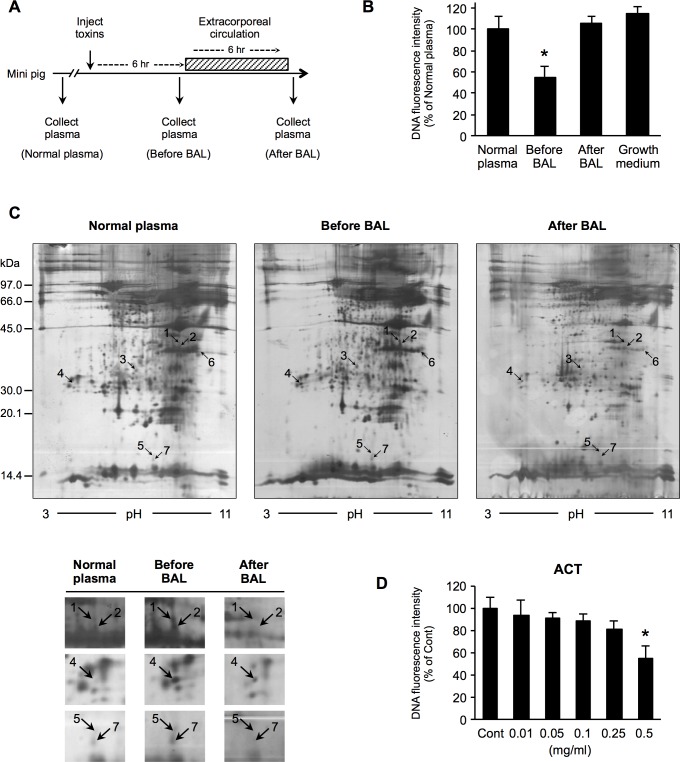
The growth and viability of human astrocytes cultured with plasma from mini-pigs with HE and the identification of candidate causative factors for HE by a 2-DE-based proteomic analysis (A) Experimental design: Mini-pig plasma was collected before the administration of α-amanitin and LPS, when encephalopathy occurred after the addition of toxins, and after treatment with extracorporeal circulation. (B) Astrocytes were cultured in medium with the collected plasma for 24 h. (C) Representative 2-DE gel images of silver-stained plasma proteins. These were based on LC-MS/MS data obtained from the NCBInr database using the MASCOT searching program. The labels 1 to 7 indicate the seven proteins that were upregulated before BAL treatment in comparison to normal plasma and which were downregulated after BAL treatment in comparison to before BAL treatment. (D) Astrocytes were incubated with various concentrations of ACT (0.01–0.5 mg/ml) for 24 h. Cell nuclei were counterstained with Hoechst 33342 with wavelengths of 350 nm excitation and 460 nm emission. Bars indicate the mean ± standard error of the mean (n = 5). *p < 0.05, in comparison to control (normal plasma).